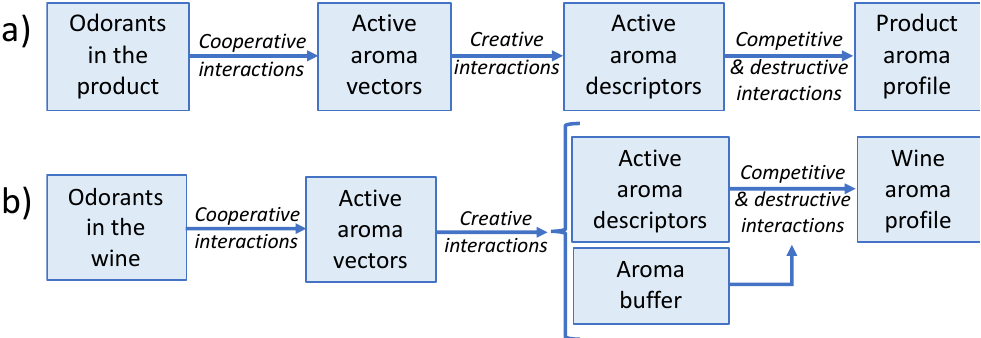
Figure 7. Schemas showing the use of perceptual interactions for interpreting the role of compositional odorants in the final sensory descriptors of any product (7a) or specifically of wine (7b).